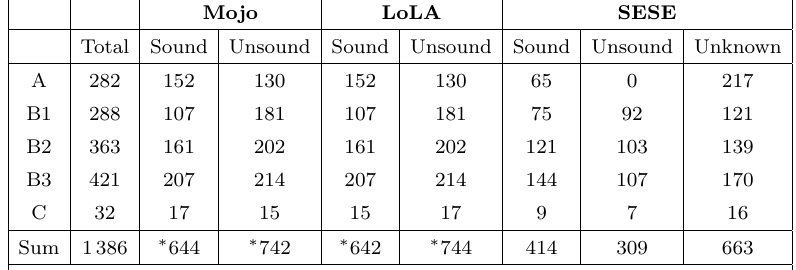
Table 2. The number of sound, unsound, and unknown workflows identified by the different tools Mojo LoLA